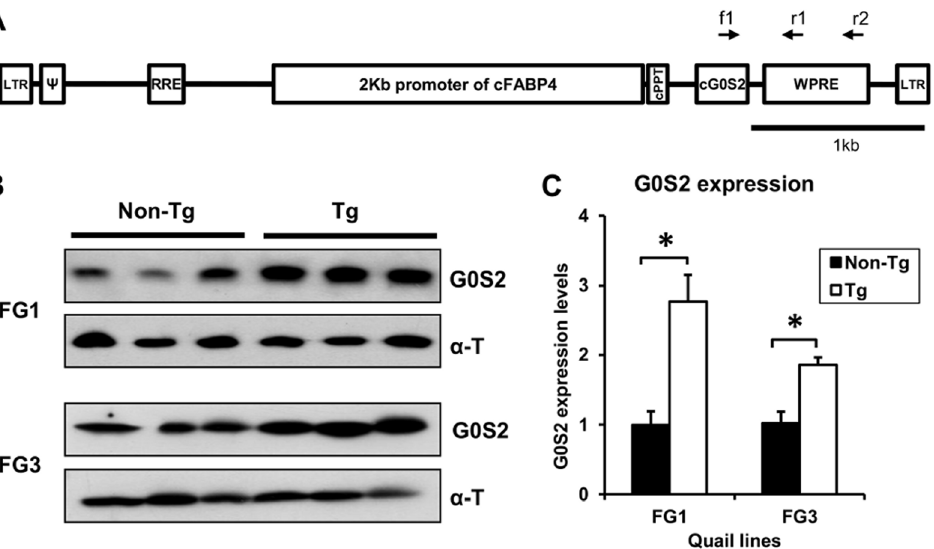
Figure 1. Lentiviral vector construct and its expression in adipose tissues of transgenic quail. (A) Diagram of lentiviral vector used for producing transgenic quail. The vector contains 2 kb promoter of chicken fatty acid binding protein and chicken G0S2 coding DNA sequences. The primers for detecting the transgene are presented as f1 for forward primer (LTG0S2-F) and r1 and r2 for reverse primers (LT-R and WPRE-R, respectively). (B) and ( C ) The expression level of G0S2 protein in adipose tissues of adult transgenic (Tg) and non-transgenic (Non-Tg) quail. Values are represented as mean 6 SEM (n=3). * indicates significance level of P , 0.05.